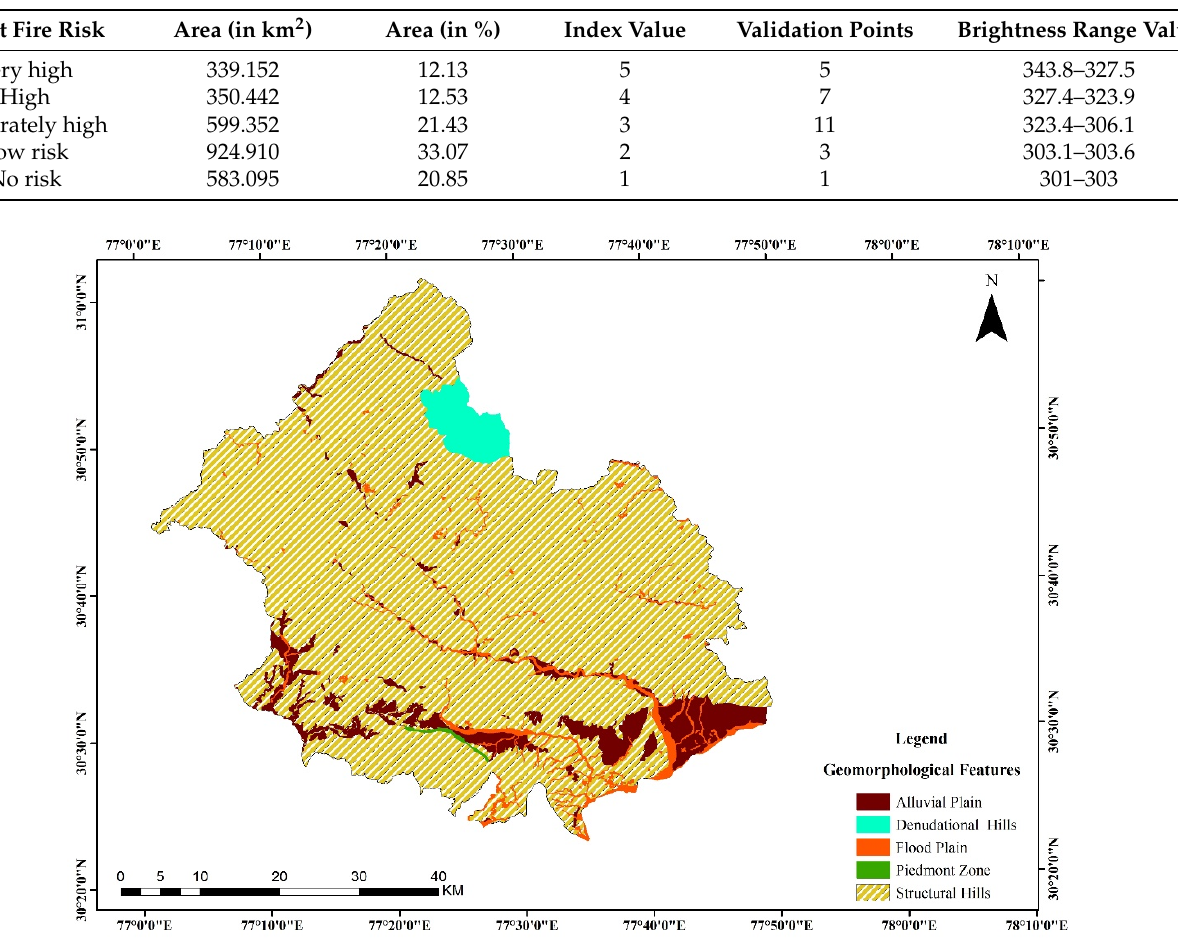
Figure 12. Geomorphology map.